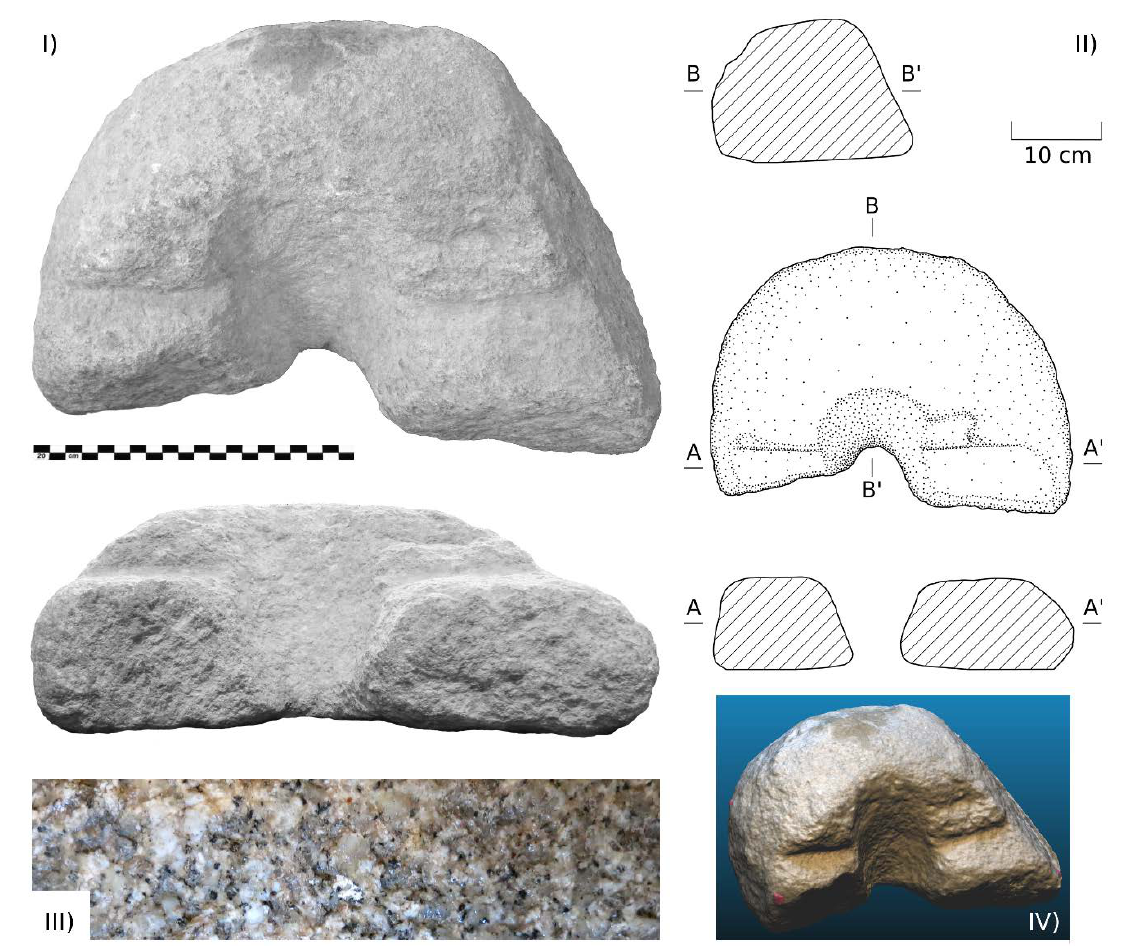
Figure 5. The Olynthus mill of unknown origin. I) Pictures (Courtesy of the Ministry of Cultural Heritage and Activities and Tourism; all rights reserved); II) Plan and section drawings; III) Detail of the granite; IV) 3D